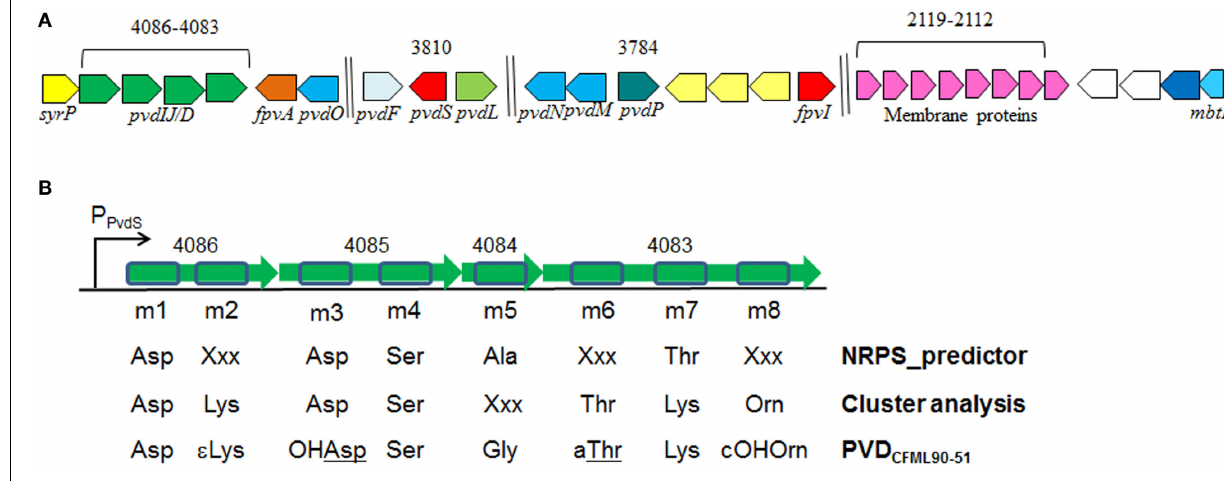
predicted adenylation domains found in the putative NRPSs (PputGB1_4083-4086) in P. putida GB-1, and the resulting peptides of each adenylation domain predicted using NRPSpredictor and cluster analysis in comparison with the reported peptide sequence of PVD CFML90 − 51 . The NRPS genes are shown in green with the adenylation domains boxed in blue.